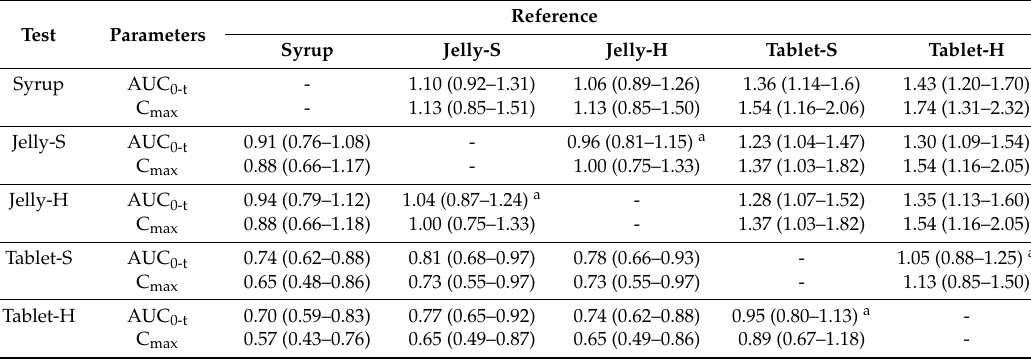
Table 6. Point estimates of mean ratio (90% confidence intervals) for